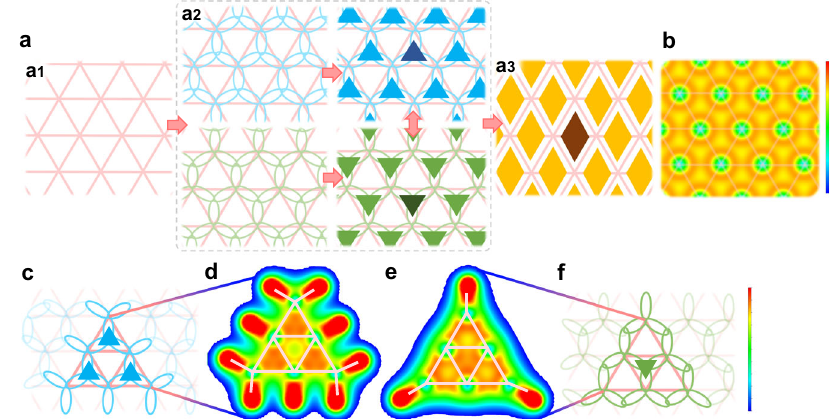
Fig. 2 | Resonant and non-resonant states of 3c-2e σ bonds in the triangular boronlattice.a Two σ resonancecontributingcon fi gurationsofatriangularboron sheet, which correspond to upwards and downwards 3c-2e bonds or triangles, respectively (a2), and one corresponding resonance hybrid structure, in which the resonance orbitals are shown by diamonds (a3). b The valence electron charge